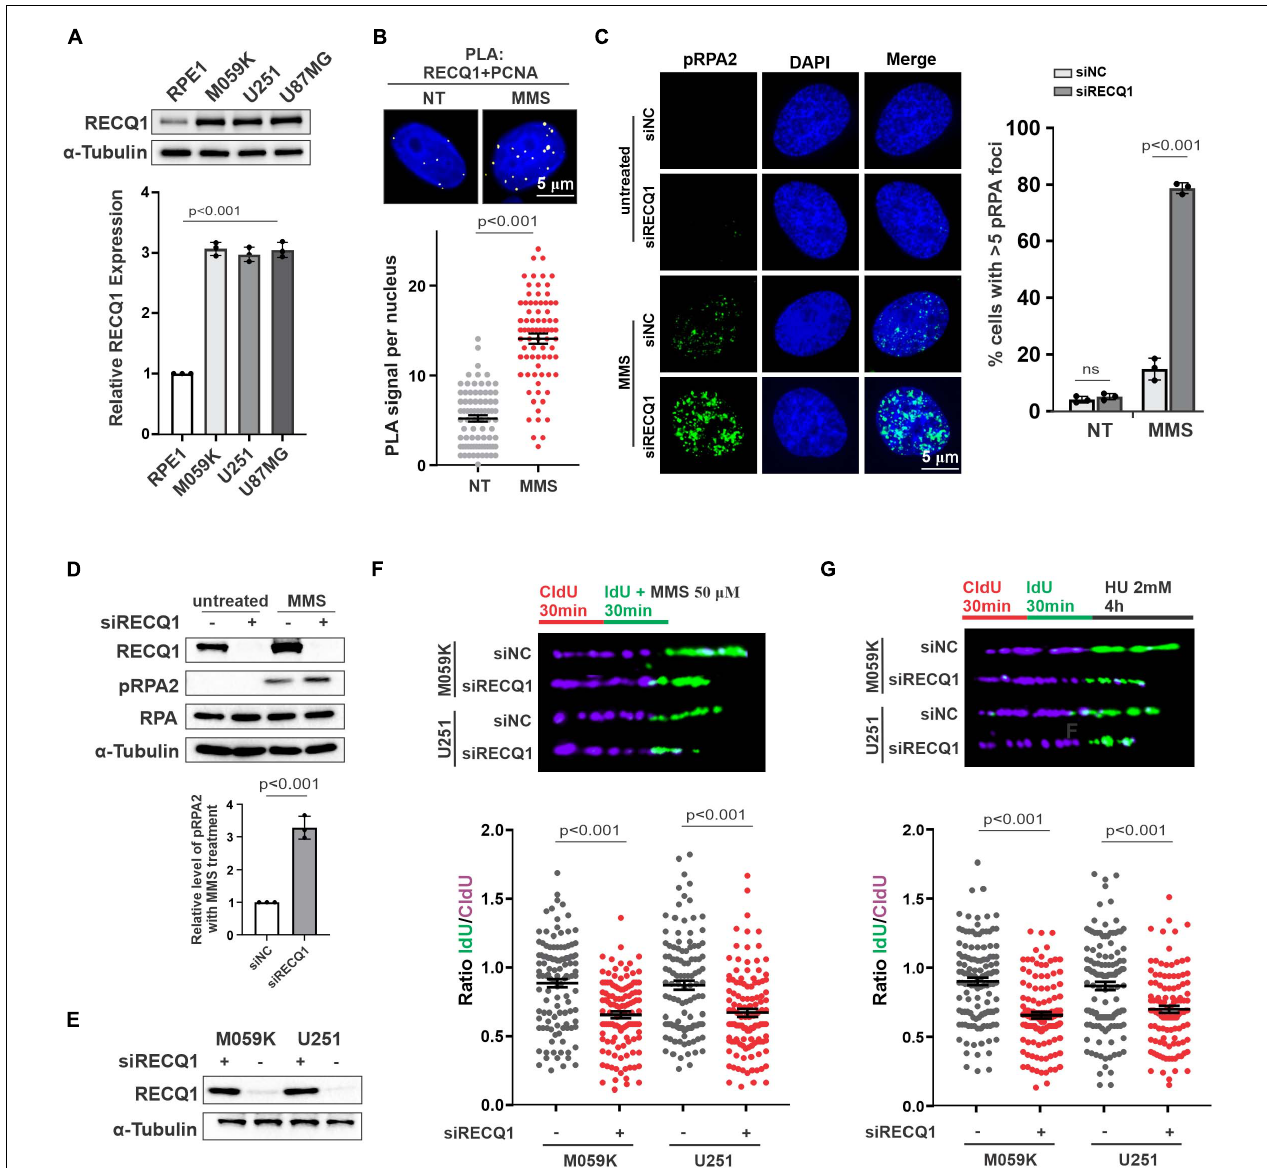
FIGURE 1 | RECQ1 is critical for replication fork restoration in response to replication stress. (A) Whole-cell lysates from different cell lines were analyzed by western blotting using indicated antibodies against RECQ1 and α -Tubulin, indicating RECQ1 is overexpressed in GBM cell lines. (B) Detection of RECQ1-PCNA interaction was carried out by PLA labeling in M059K cells treated with or without 50 µ M MMS. Representative images are shown. Scale bars, 5 µ m. The scatterplot displays quantification of the PLA signals per nucleus from three independent experiments. Data are mean ± SEM. (C) M059K cells were transfected with siNC or siRECQ1 for 48 h and then treated with the MMS or not. Immunofluorescence labeling was performed to detect level of pRPA2 for ssDNA accumulation analysis. Quantitation of pRPA2 was presented from three independent replicates. Data are mean ± SD. (D,E) Whole-cell lysates from different cell lines with MMS treatment or not were analyzed by western blotting using the indicated antibodies. (F,G) Schematic of the CldU/IdU pulse-labeling analysis used to investigate nascent Strand degradation upon MMS or HU treatment in M059K and U251 cells transfected with siRECQ1 targeting RECQ1 for 48 h. Representative images of CldU and IdU replication tracks (top) and scatterplot of IdU/CldU-tract length ratios (bottom) for replication forks are shown. Fiber evaluated from at least 100 events from three independent experiments. Data are mean ± SEM. A two-sided Mann–Whitney rank-sum test was used to determine if differences were significant (B,F,G) . A two-sided unpaired t -test was used to calculate P -values (C) . Significant: p < 0.05; NS, not significant: P >